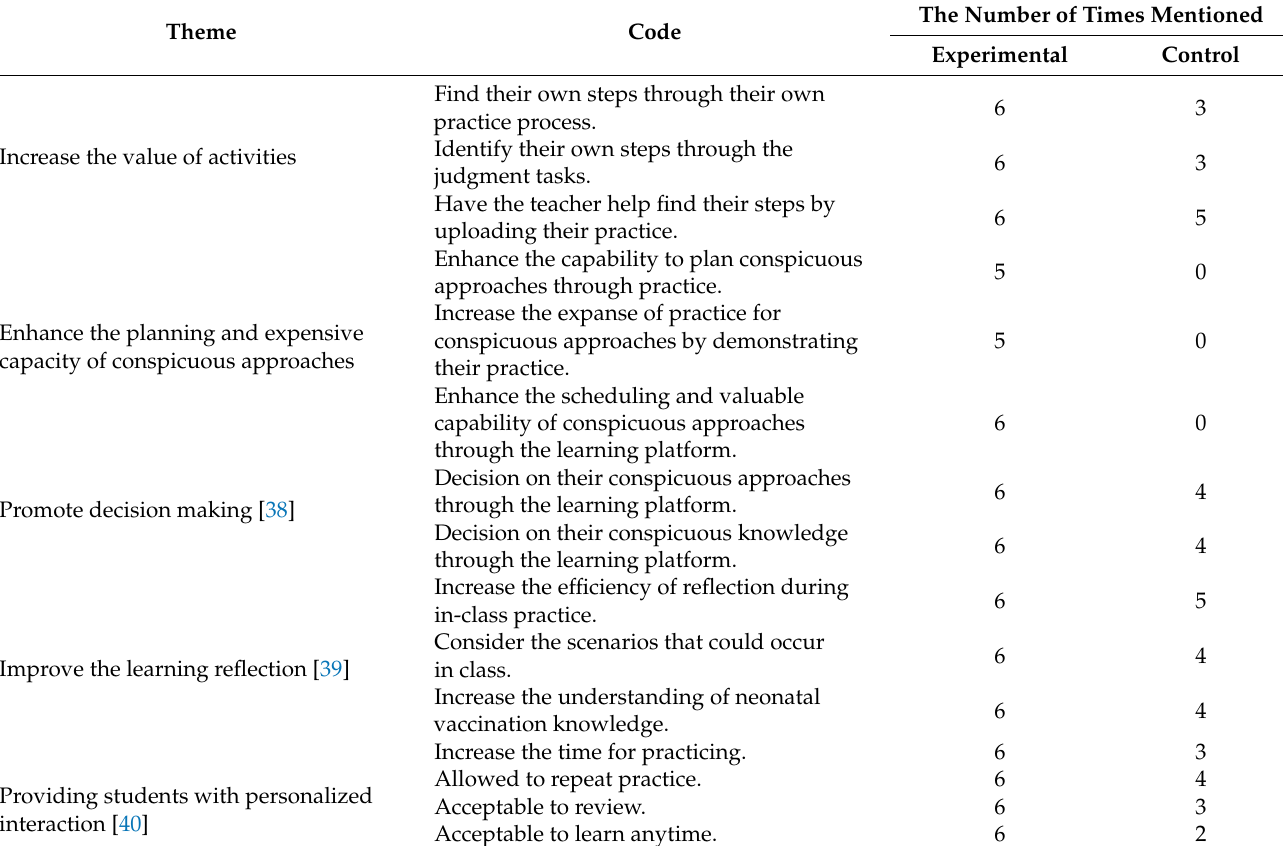
Table 1. Themes, coding items, and number of occurrences of the interview